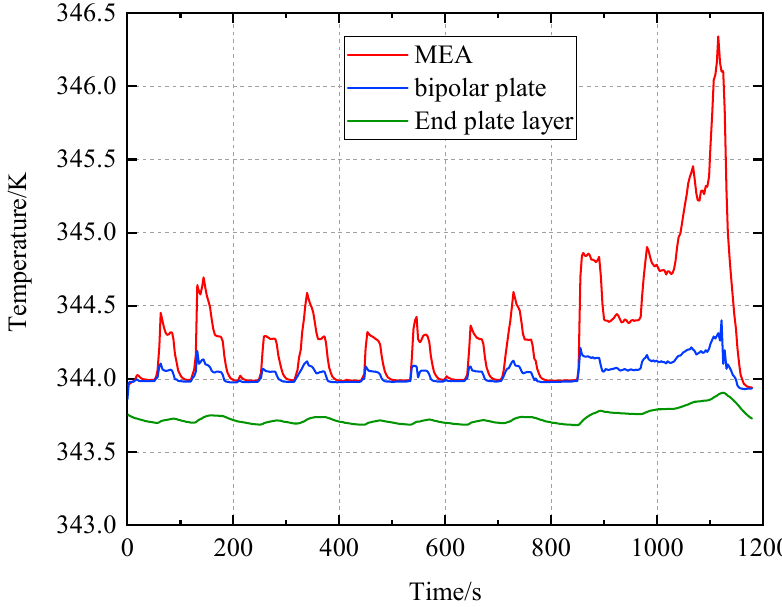
Figure 13. Diagram of temperature variation inside a fuel cell.